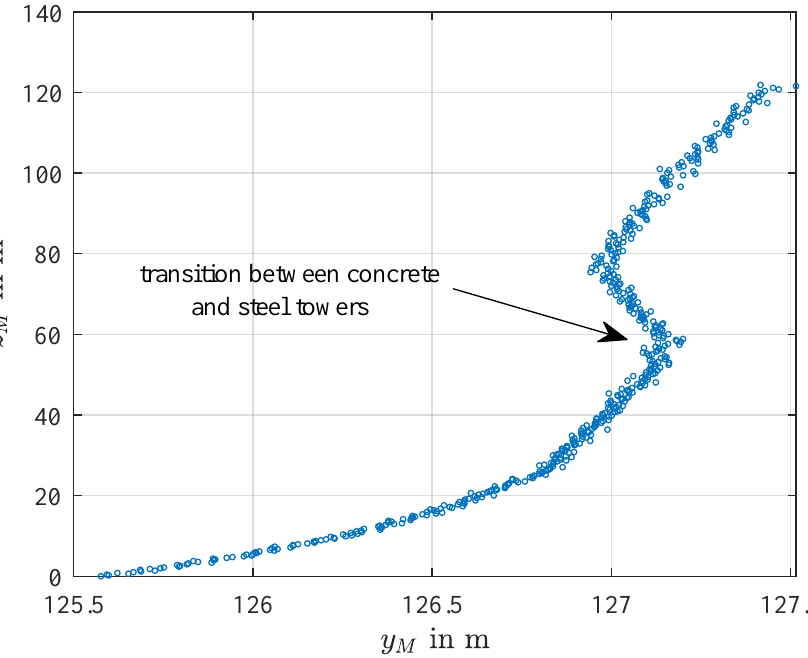
Figure 8. Contour line measured with vertical scanner